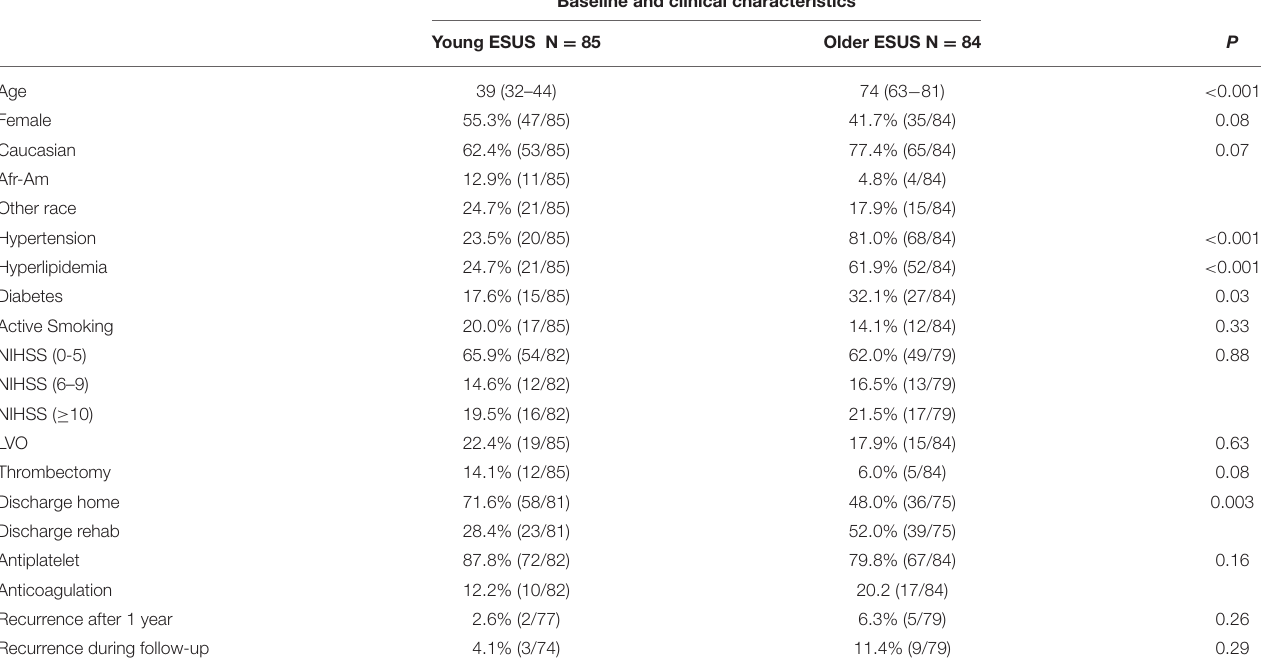
TABLE 2 | Baseline and clinical characteristics.